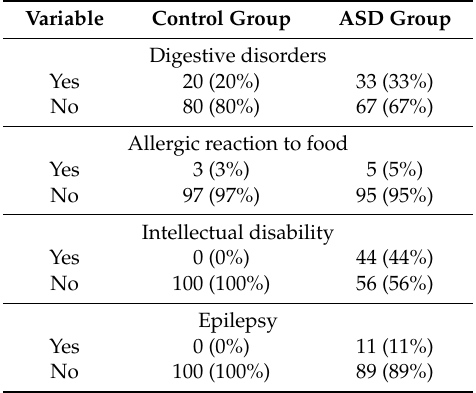
Table 2. ASD comorbid disorders.